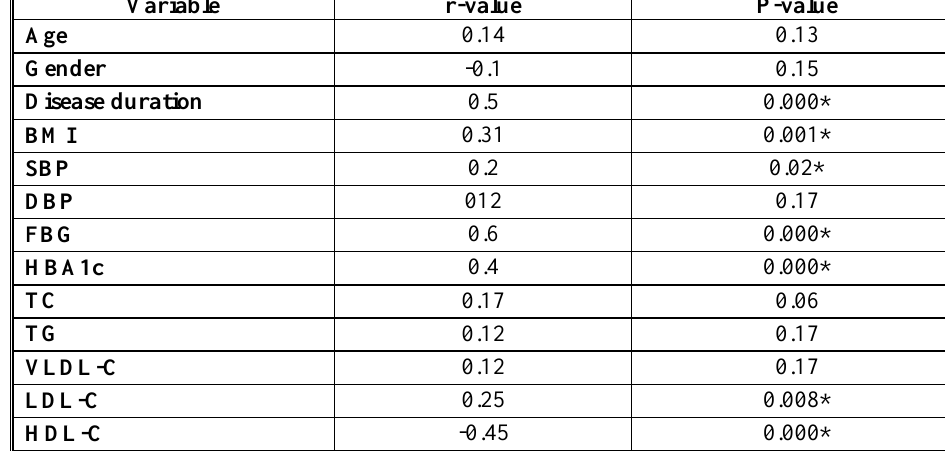
Table- 4. Pearson’s correlations of serum RBP4 levels with the studied